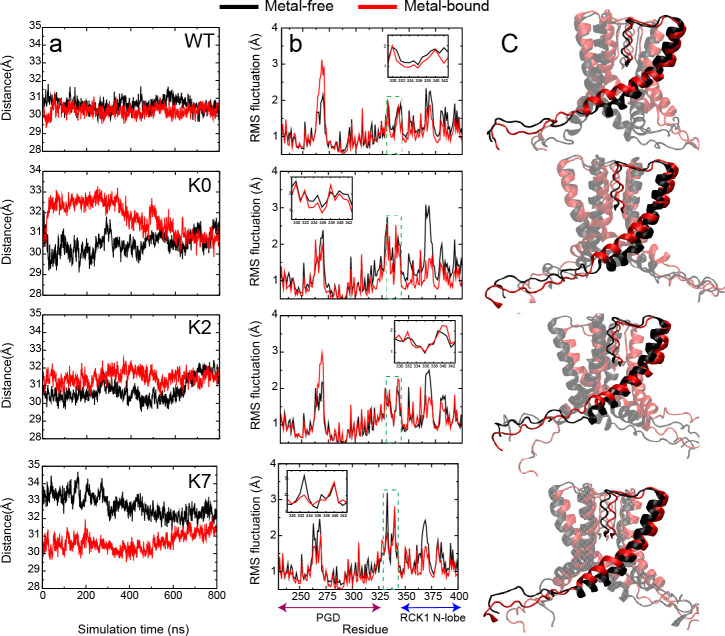
Structural and dynamic properties of the C-linker in WT hSlo1 and mutants.(a) The C-linker N-C distance (329–343 Cα) as a function of time during 800-ns MD simulations. (b) RMSF profiles of residues 230–400 (PGD, C-linker and RCK1 N-lobe) derived from the same MD trajectories, showing limited flexibility of the C-linker (green dashed box and in inserts). (c) Representative snapshots showing the equilibrated conformations of C-linkers in both metal-bound and free states. See Materials and methods for the details of the calculations.